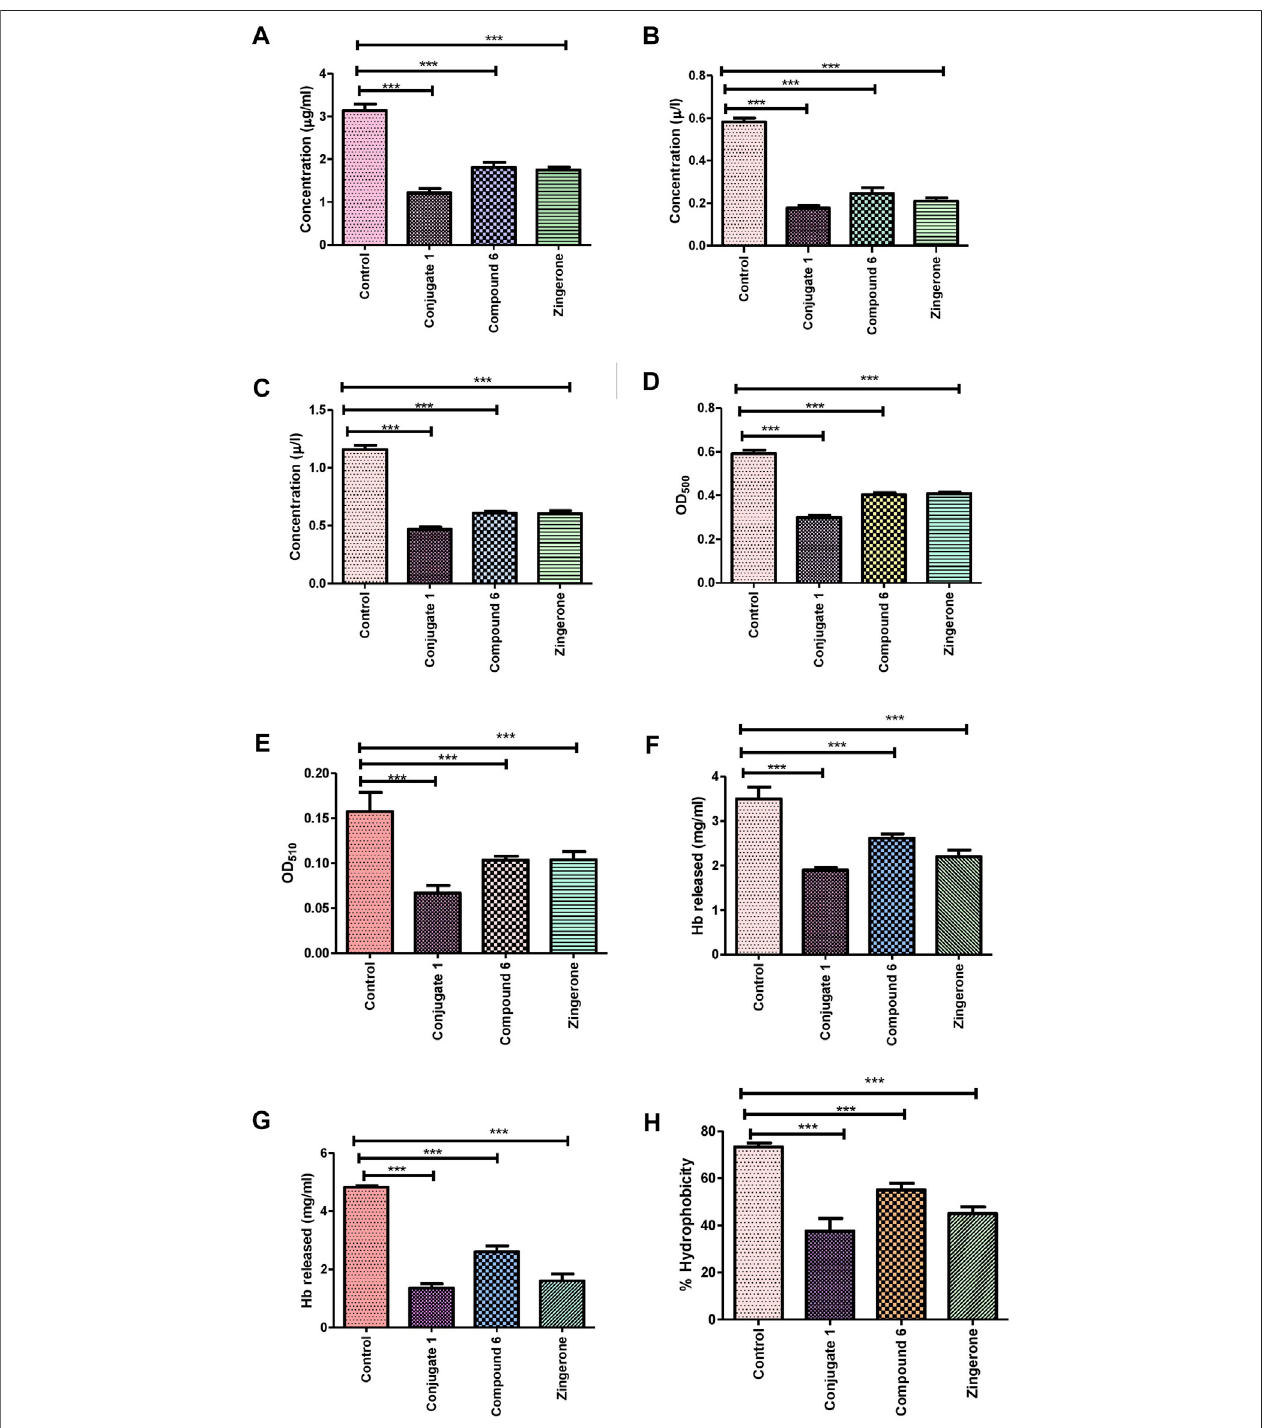
FIGURE4| Effectofsub-MICofcatechol – zingeroneconjugate( 1 ),compound( 6 ),andzingeronealone,onthevirulencefactorsin P.aeruginosa . (A) Pyocyanin, (B) protease, (C) elastase, (D) alginate, (E) pyochelin, (F) cell-free Hemolysin, (G) cell-bound hemolysin, and (H) cell surface hydrophobicity.